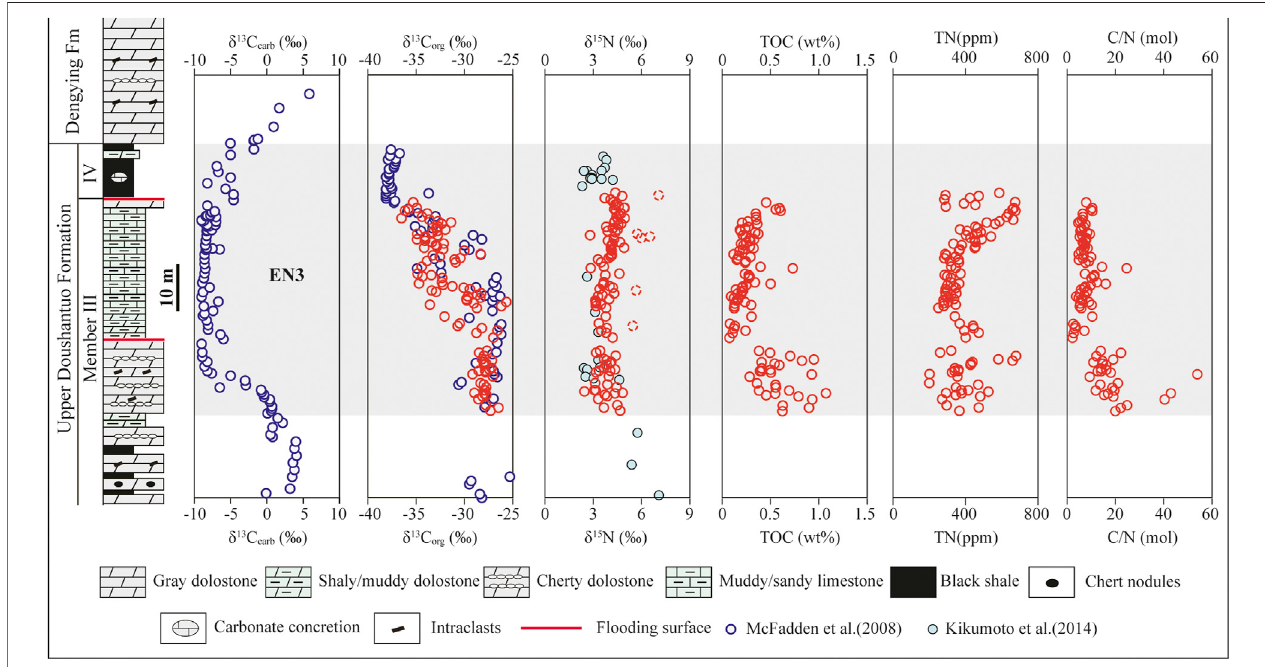
FIGURE 2 | The geochemical pro fi les of δ 13 C carb , δ 13 C org , δ 15 N, TOC, TN and MC/N spanning the Shuram-EN3 excursion in the Jiulongwan section. The data points with dashed outline fall away from the general trend.